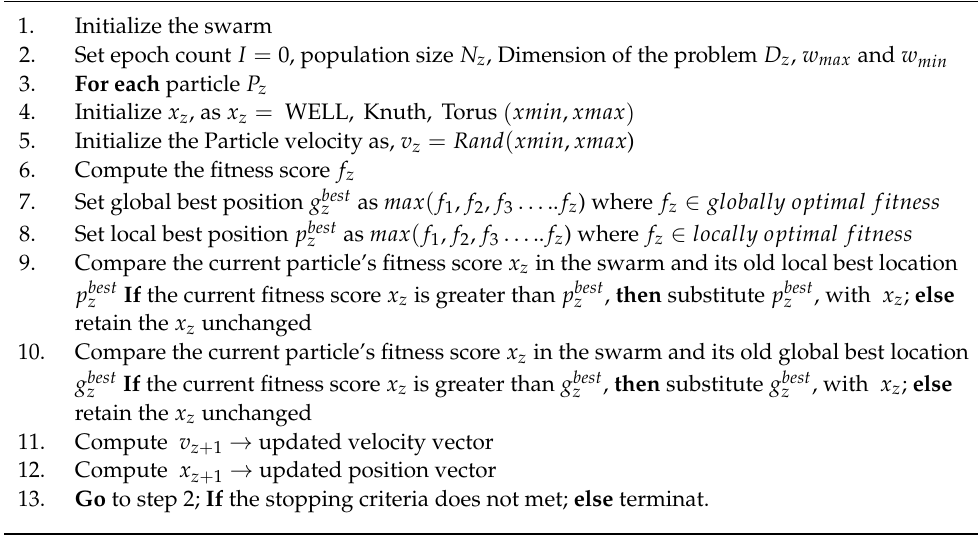
Algorithm 3 Proposed Pseudocode of PSO Using Novel Method of Initialization